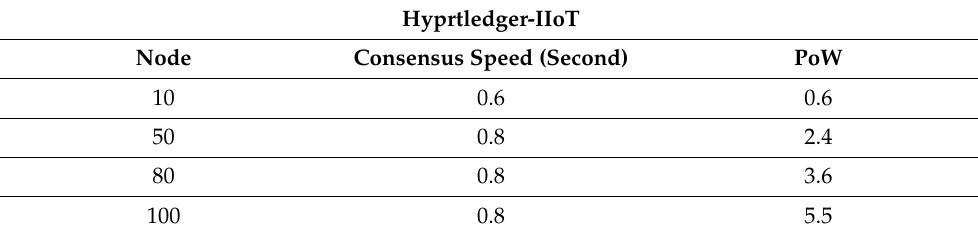
Figure 25. Consensus speed comparison between Hyperledger-IIoT and PoW(Proof of Work). Table 2. Consensus